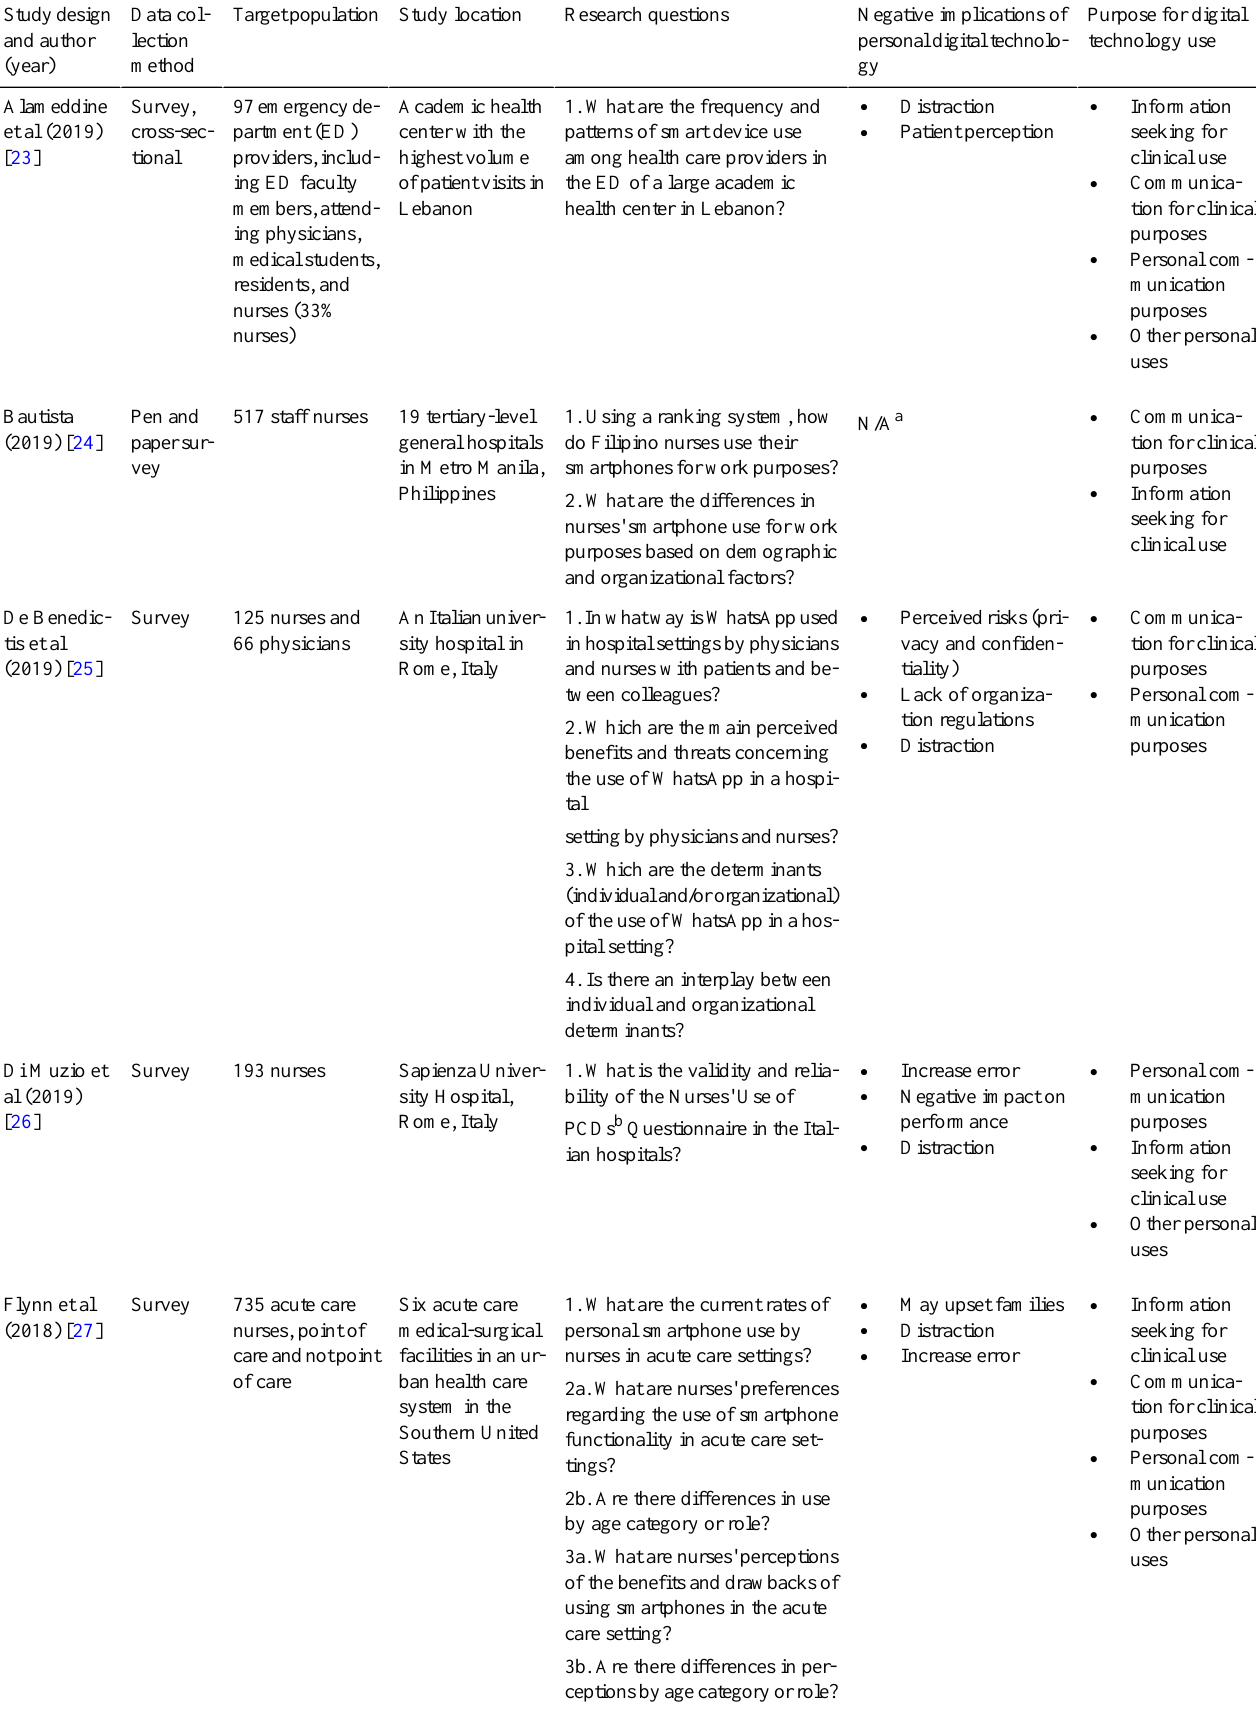
Table 1. Included quantitative